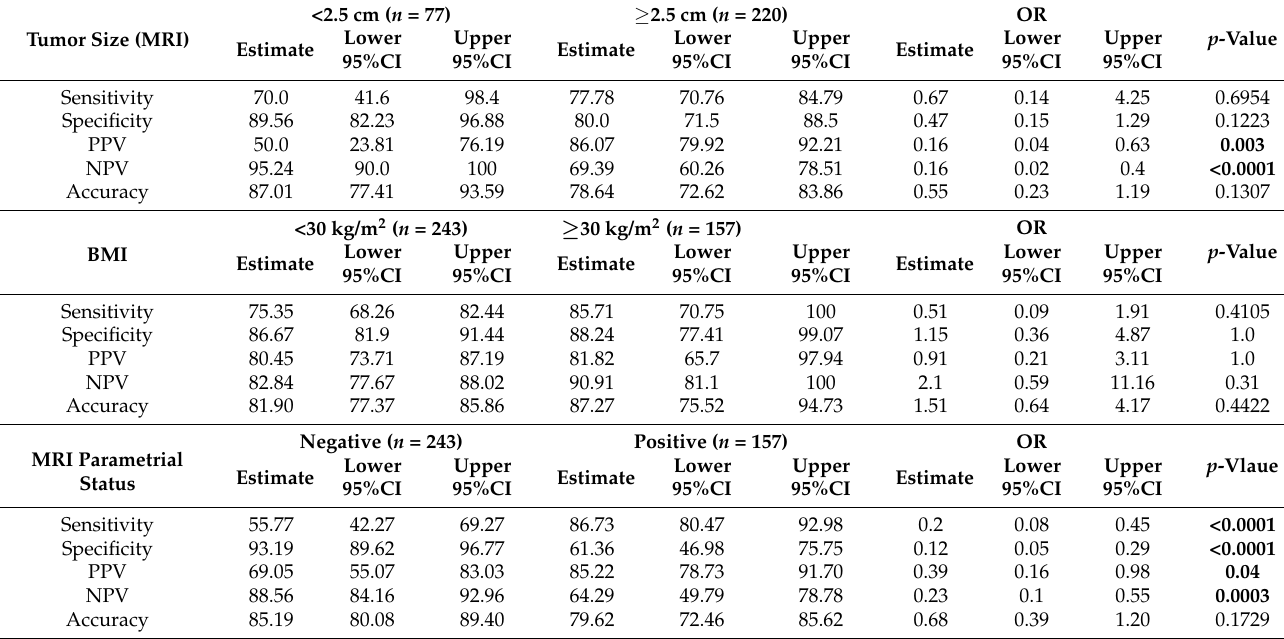
Table 4. Factors influencing diagnostic performance of aEUA in detecting pathologically confirmed parametrial tumor infiltration.